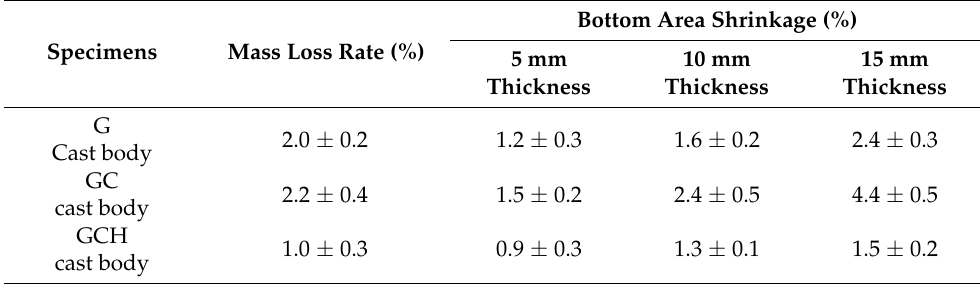
Table 1. Mold and casting body shrinkage rate (%) for each process according to the thickness of the outer wall of the box mold.